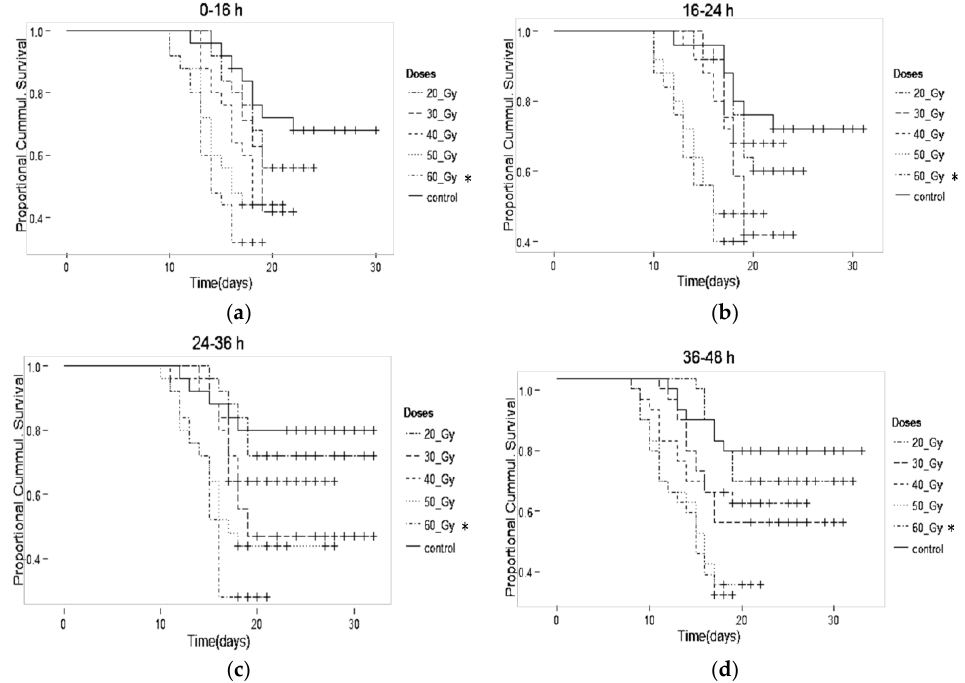
Figure 2. Adult male survival for pupae irradiated at different ages ( a ) 0 – 16, ( b ) 16 – 24, ( c ) 24 – 36, ( d ) 36 – 48 h). * Adult male at a dose of 60 Gy in (P) generation.